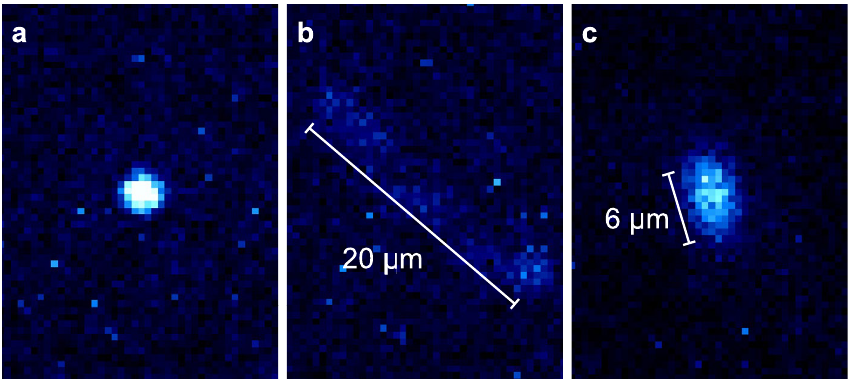
Figure 7. Camera image comparison between having the vacuum chamber ( a ) at rest, ( b ) vibrating at 34 Hz with an apparent peak acceleration of 0.047(5) g and ( c ) vibrating at 300 Hz with an apparent peak acceleration of 1.09(18)